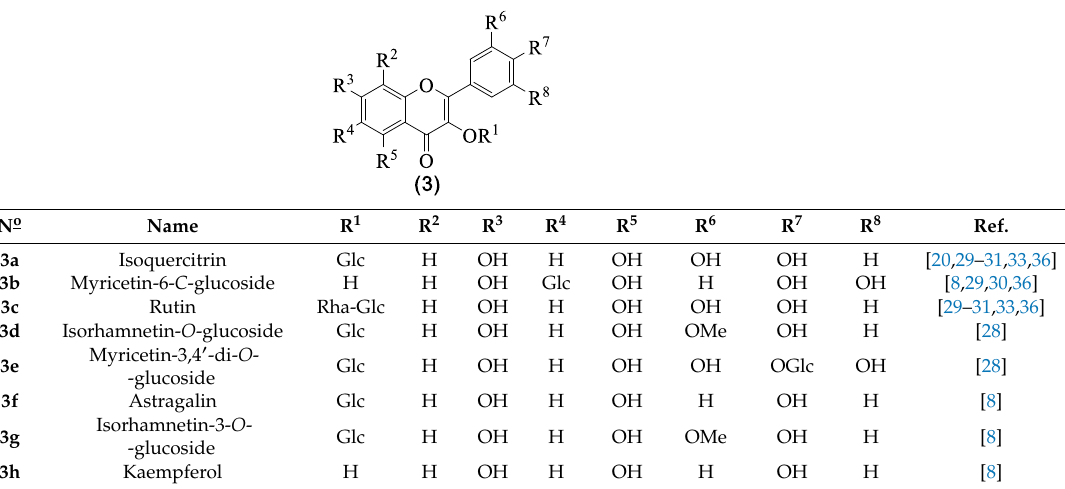
Table 3. Flavonols produced by G. tridentata .